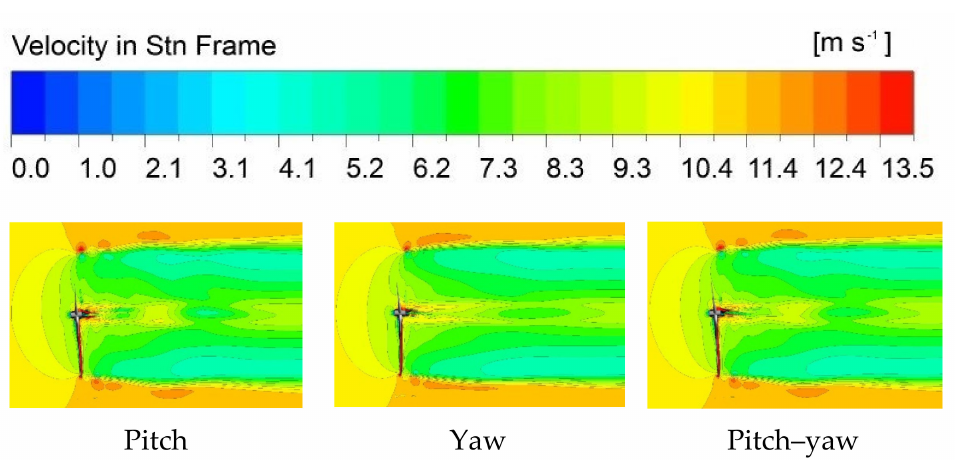
Figure 19. Velocity distribution at Position